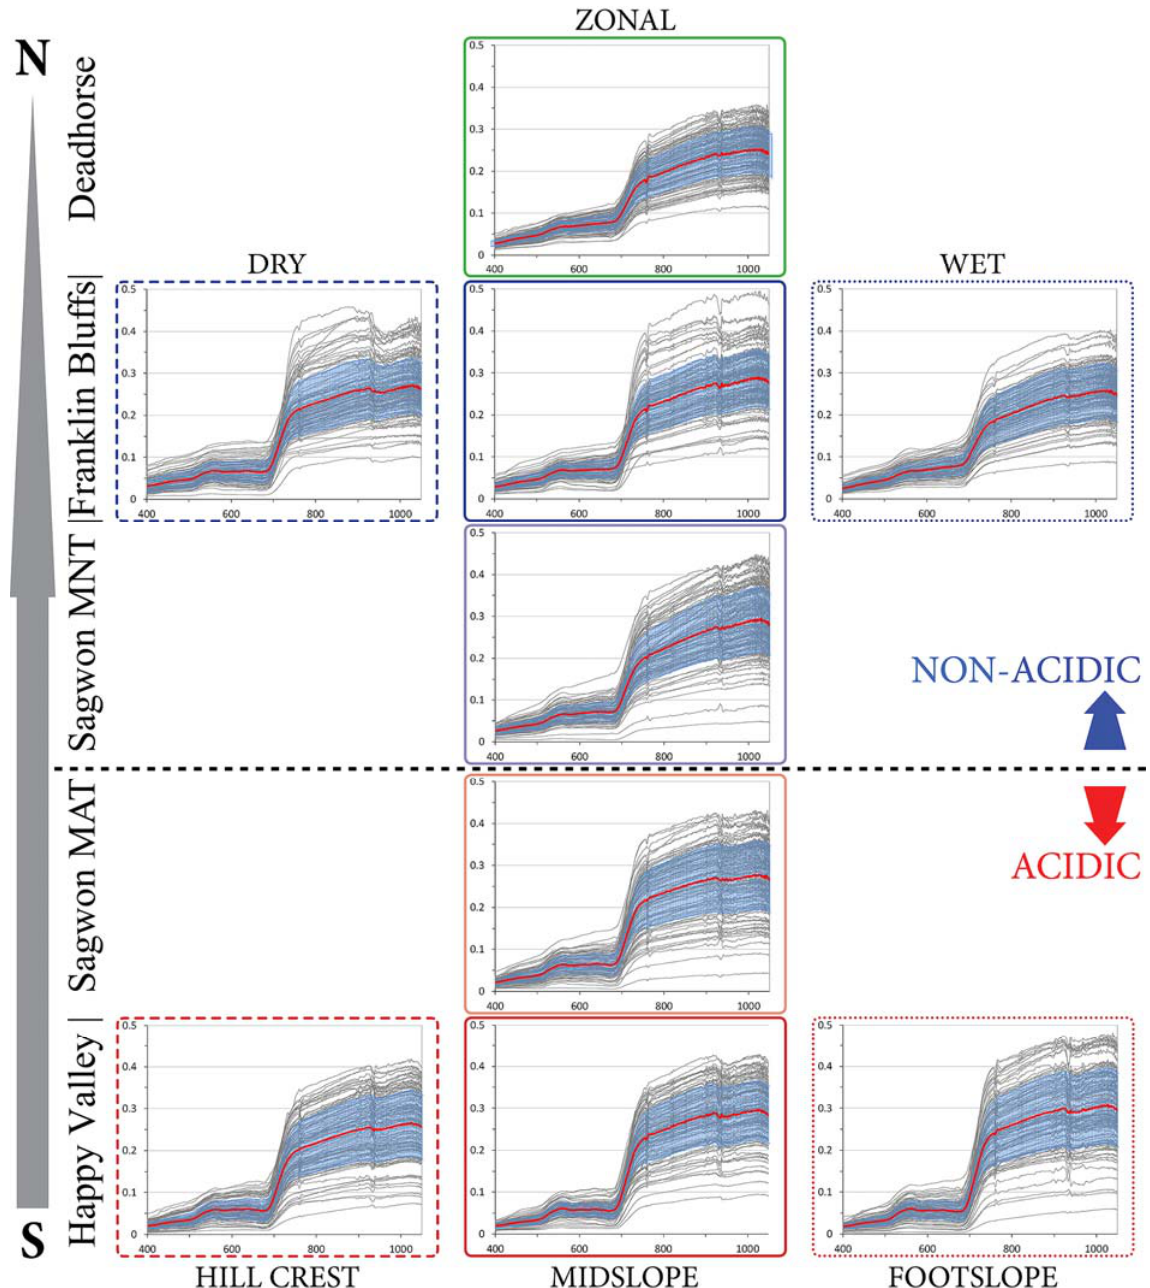
Figure 6. Hyperspectral reflectance spectra of the study sites (grey lines: reflectance spectra of each quadrat; red line: averaged reflectance spectra representing the arctic tundra vegetation community of the study site; blue area: standard deviation of spectral